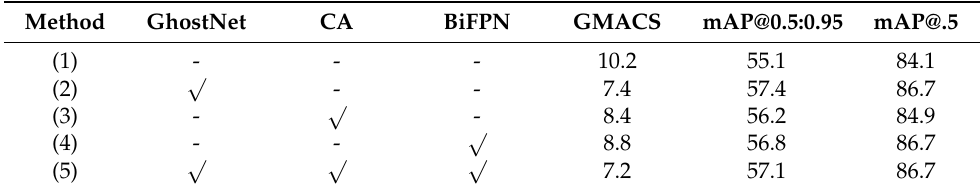
Table 5. Ablation Experiment Configuration and Results. module